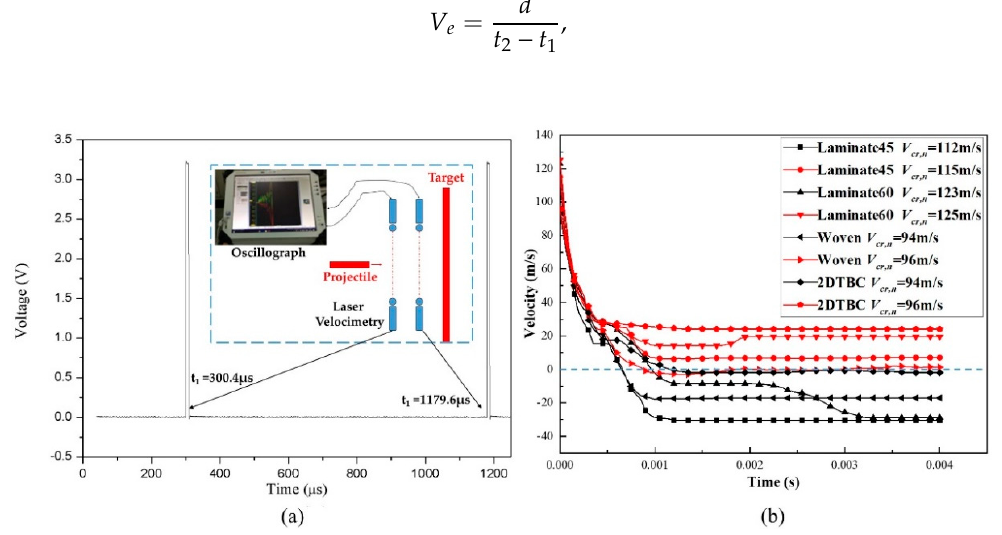
Figure 3. ( a ) Laser velocimetry test system in experiments, ( b ) numerical simulation results of the projectile velocity profiles for the impact tests against different composite panels.